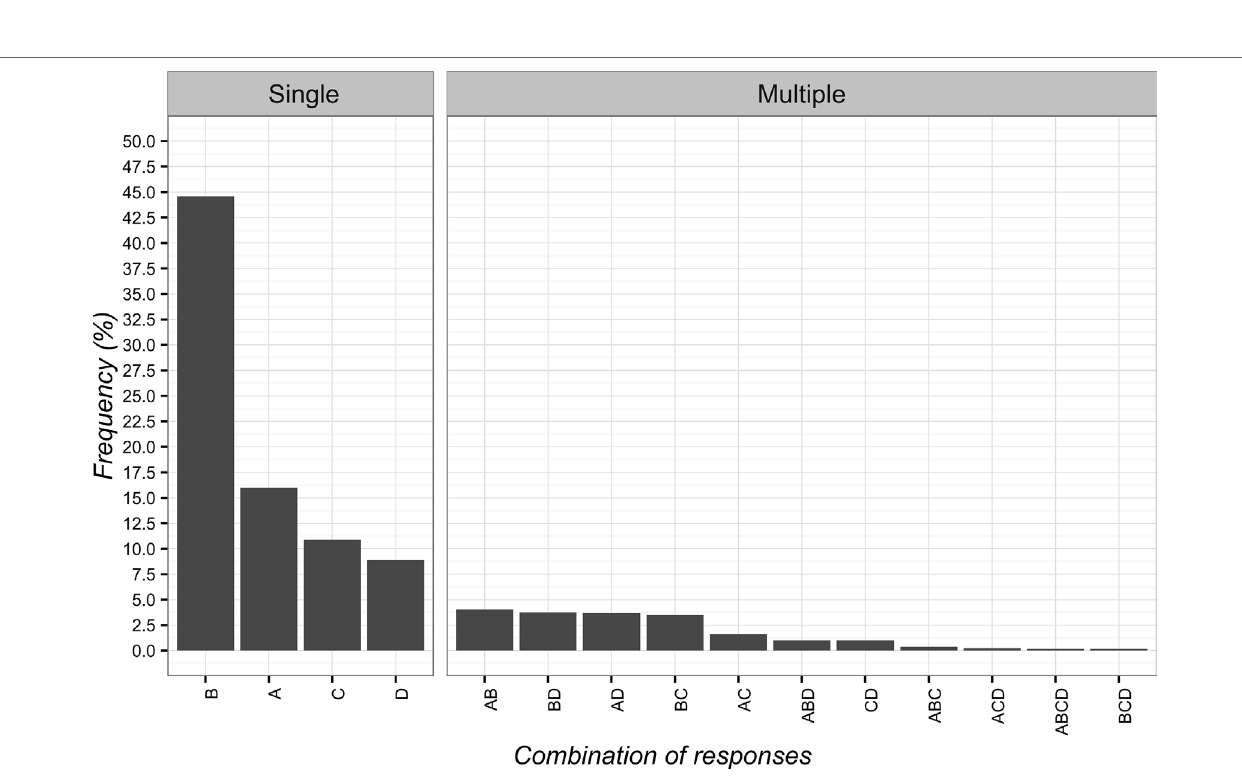
FIGURE 2 | Percentages of responses for clinical vignette 2. (A) the positive attention of the healthcare team leads to decreased pain; (B) pain is not organic but psychological; (C) the patient is very suggestible; (D) the supporting patient saw an improvement after treatment with laser switched off.